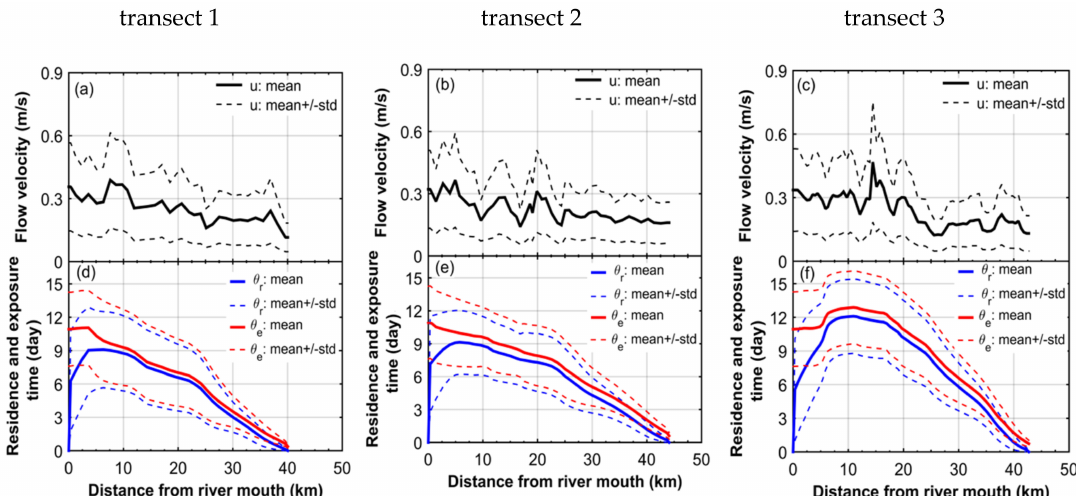
Figure 8. Simulated values of water velocity along the: ( a ) transect 1; ( b ) transect 2; ( c ) transect 3 (see Figure 3) and simulated values of residence and exposure times along; ( d ) transect 1; ( e ) transect 2; ( f ) transect 3 (see Figure 3) for the low flow